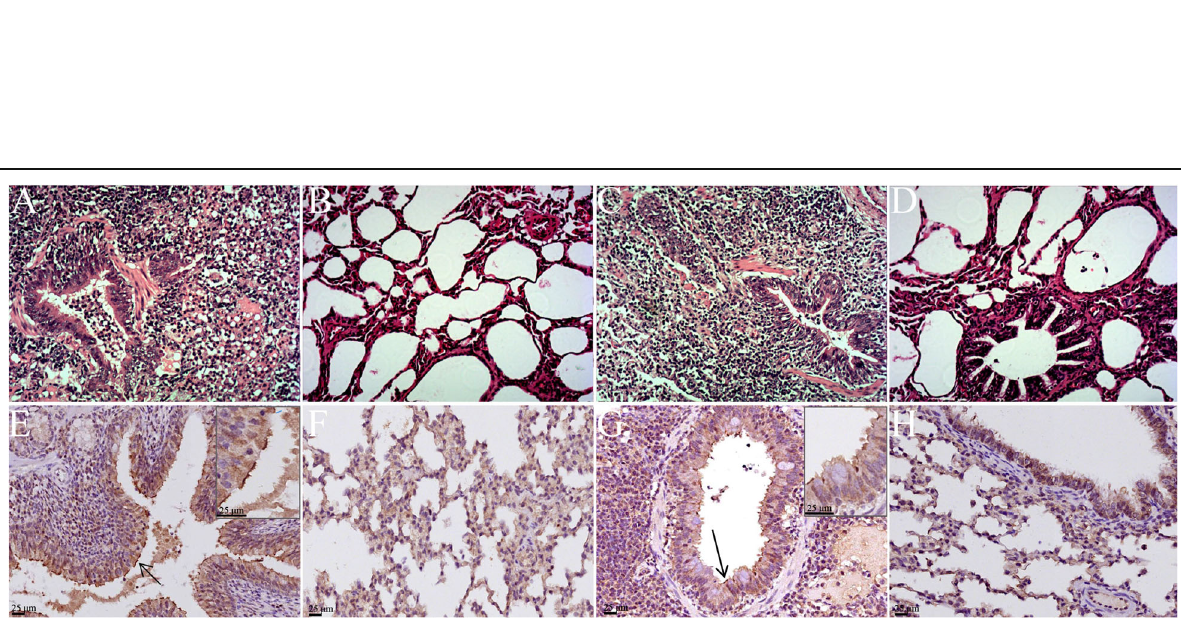
Fig. 5 Histopathological and immunohistochemical analysis of lung samples. a and b represent histopathological findings of lungs collected from Bama miniature pigs in the M. hyopneumoniae strain JS-infected group (BI) and control group (BC) at 200 × magnification, respectively. c and d are histopathological findings of lungs collected from the conventional pigs in M. hyopneumoniae strain JS-infected group (CI) and control group (CC) at 200 × magnification, respectively. All pictures were captured with the microscope of Nikon (TI-S-EJOY). e and f represent immunohistochemical observation of lungs against M. hyopneumoniae antigen P97 collected from Bama miniature pigs in the M. hyopneumoniae strain JS-infected group (BI) and control group (BC), respectively. Brown staining appeared around inner edge of bronchial lumen in the M. hyopneumoniae strain JS-infected group of Bama mininature pigs against P97R1 and was marked by short black arrows ( e ). g and ( h ) are immunohistochemical observation of lung against M. hyopneumoniae antigen P97 collected from conventional pigs in the M. hyopneumoniae strain JS-infected group (CI) and control group (CC), respectively. Similarly, brown staining appeared in group CI against P97R1 and is marked by long black arrows (G), and the enlarged image of the M. hyopneumoniae antigen P97-stained area pointed by the arrow (captured at 200 × magnification) is shown in the upper right corner (E and G). The black bar represents the scale: 25 μ m